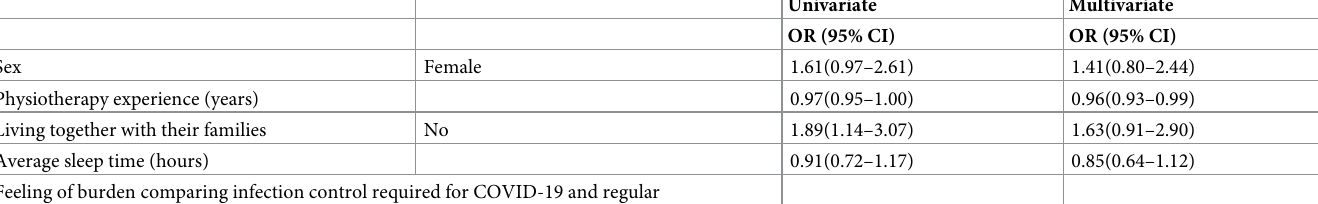
Table 3. Relationship between the burnout and working